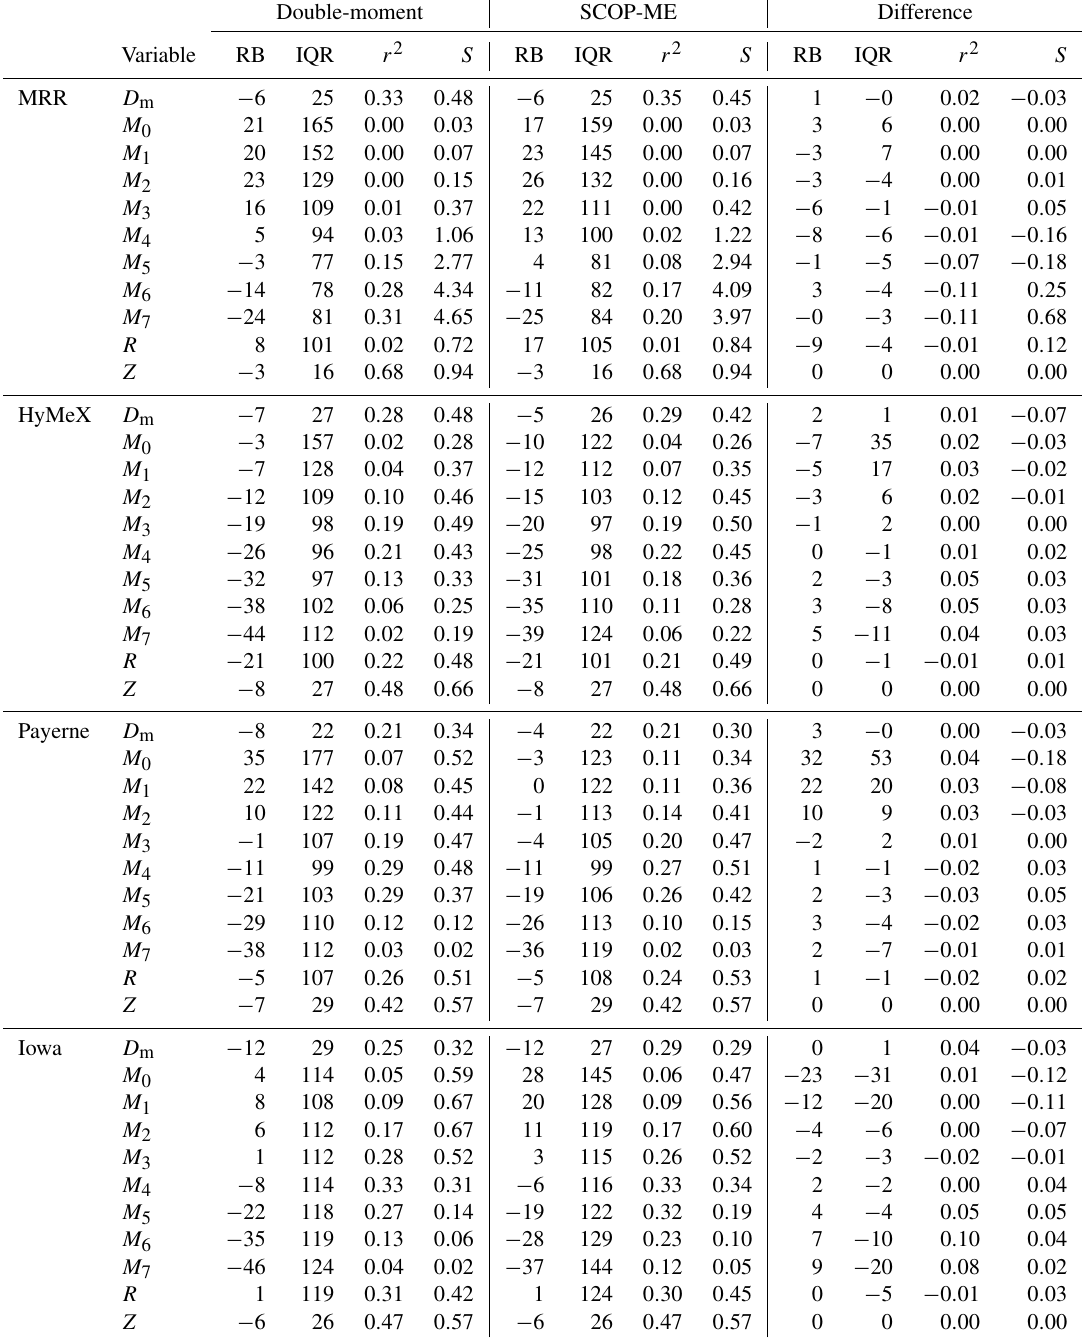
Table A4. Differences in performance by variable and region, for DSDs retrieved from noise-corrected PPI data using the double-moment technique and SCOP-ME, compared to the MRR at Pradel Grainage (MRR) and Parsivels by region (HyMeX, Payerne, and Iowa). Metrics and differences are defined as for Table A1. An exception is Z , which refers to Z H measured by the radar, not reconstructed through DSD retrieval (hence it is the same for both